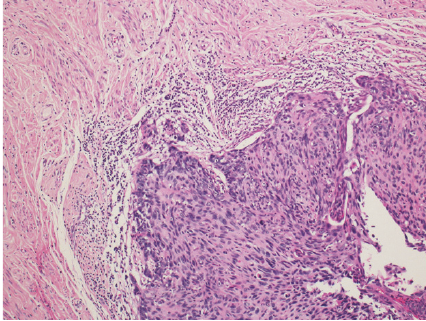
Figure 2: Histopathological examination showing grade-I endo- metrioid adenocarcinoma of the uterus (H&E stain).